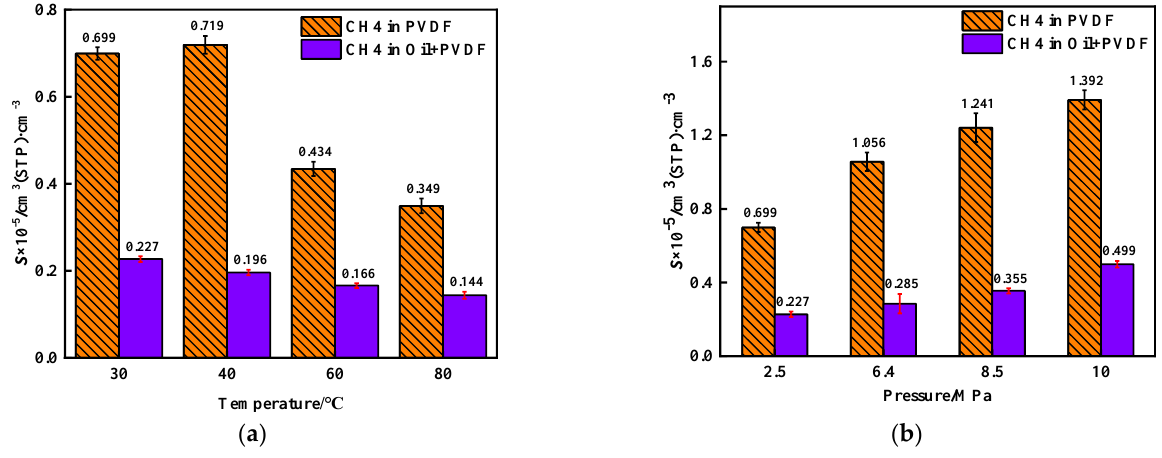
4 in PVDF containing crude oil.